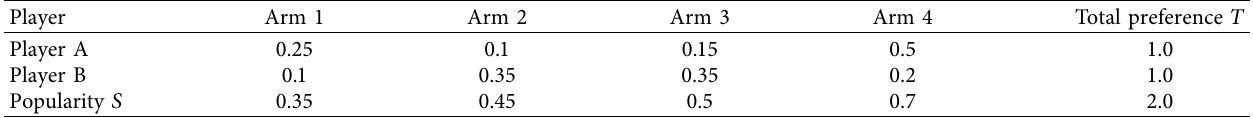
Table 6: Example of [Case